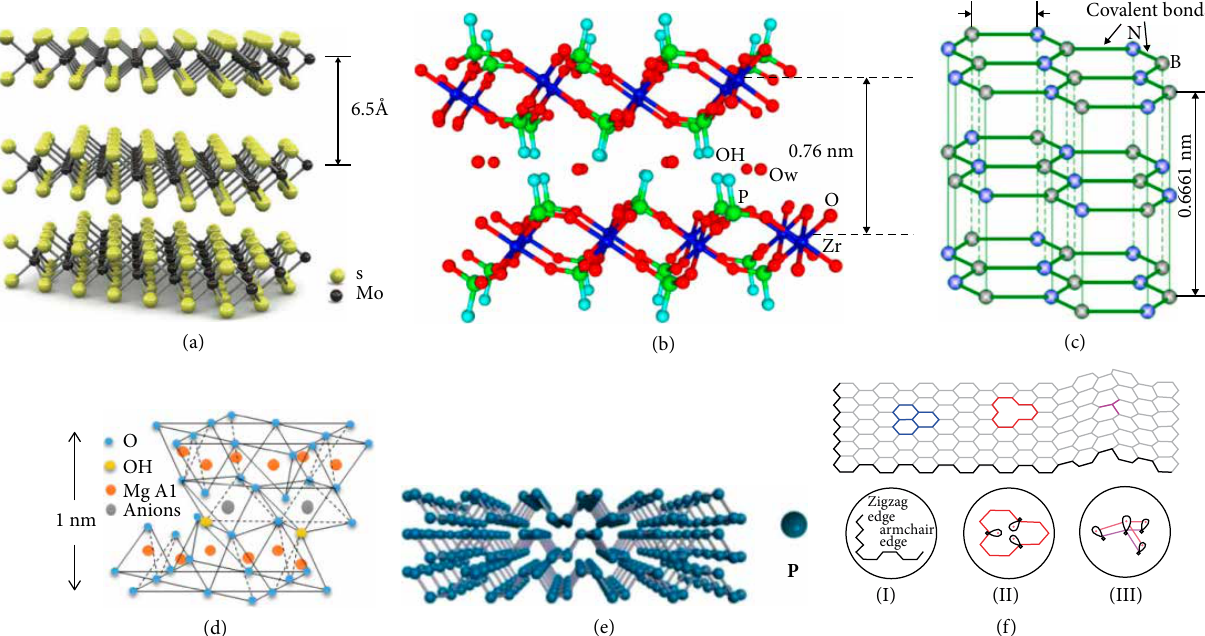
Figure 1: Structure of some two-dimensional nanomaterials. (a) Molybdenum disulfide [52]. (b) α -zirconium phosphate [53]. (c) Hexagonal boron nitride [54]. (d) Layered double hydroxide [55]. (e) Black phosphorus [56]. (f) Graphene with (I) Zigzag and armchair edges, (II) Monovacancy, (III) Local structure of a curved graphene sheet